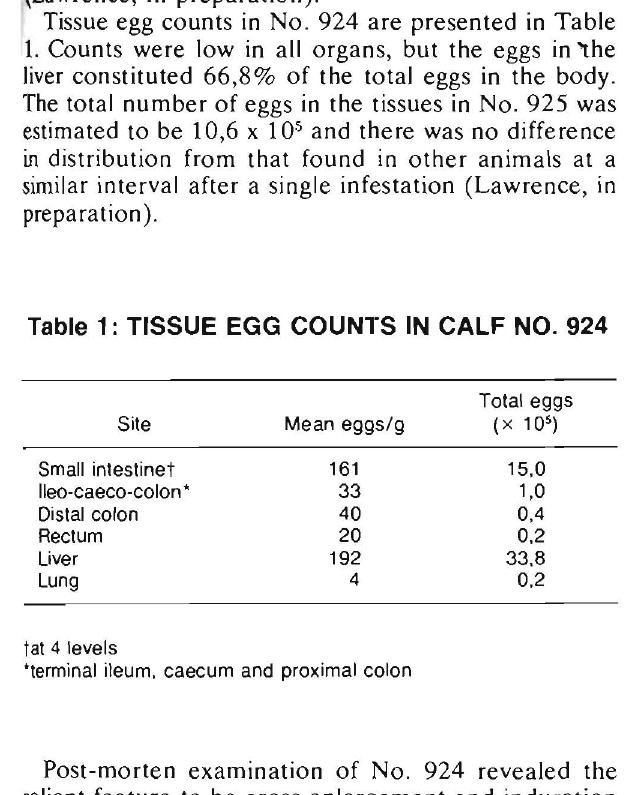
Fig. 4 Foci of piecemeal necrosis adjacent to portal tract. x 250.